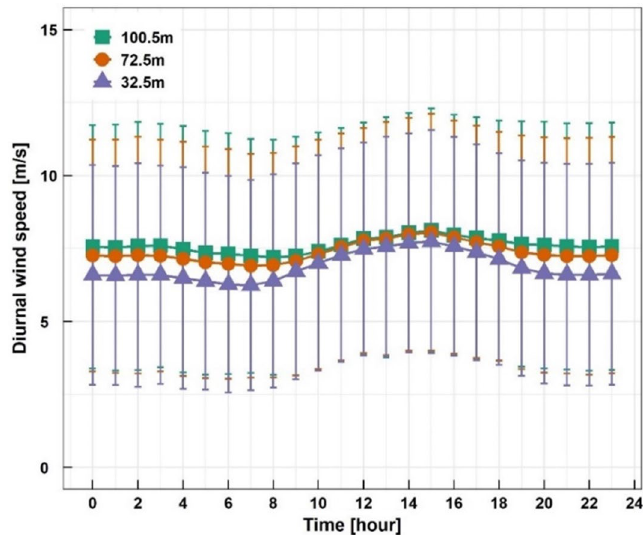
Figure 4. Diurnal wind speed variation.